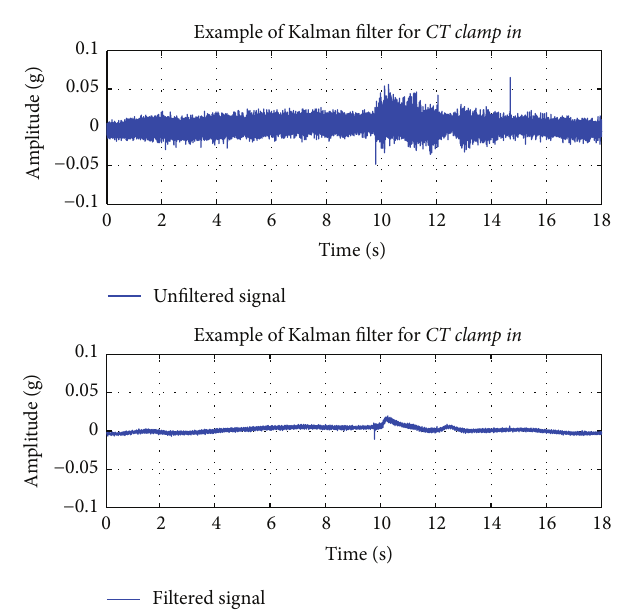
Figure 9: Example of filtered